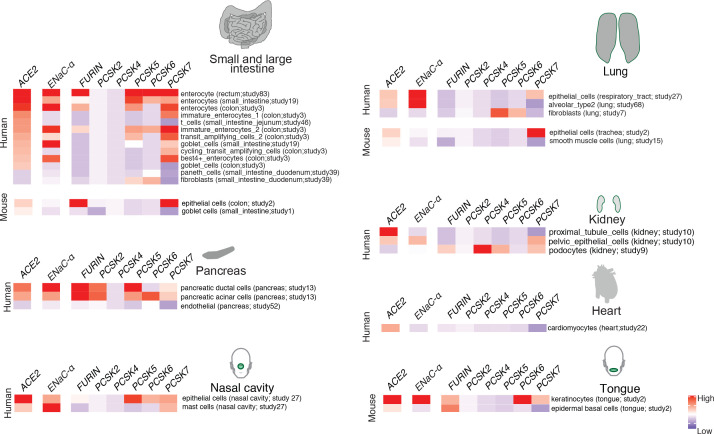
Expression profiling of identified proteases.The heatmap depicts the relative expression of ACE2 and ENaC-ɑ along with a list of proteases that can potentially cleave the S1/S2 site. The relative expression levels are denoted on a scale of blue (low) to red (high). The rows denote proteases and columns denote cell-types.